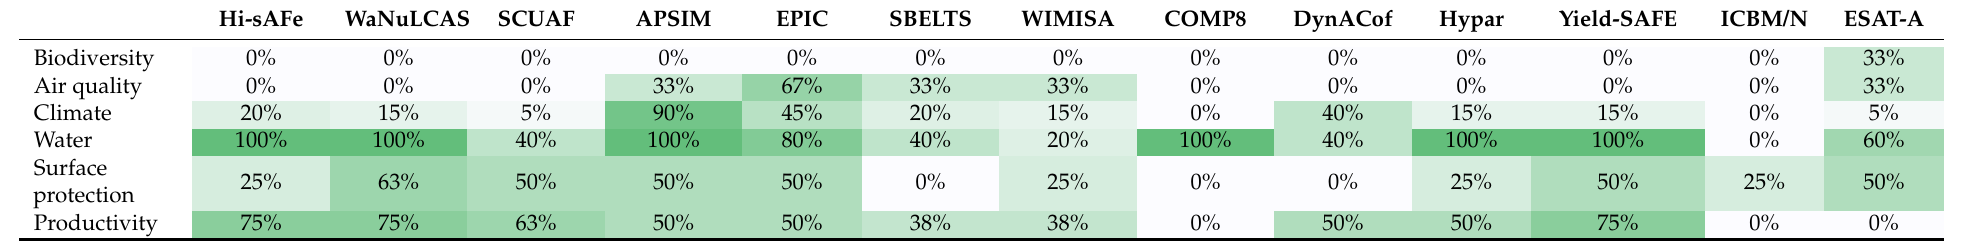
Table 3. Average coverage value for the models to assess NCP-related ecosystem properties. Shading emphasizes higher coverages. The coverage percentage is derived from Table A1. Hi-sAFe WaNuLCAS SCUAF APSIM EPIC Hypar Yield-SAFE ESAT-A Biodiversity Climate Water Surface